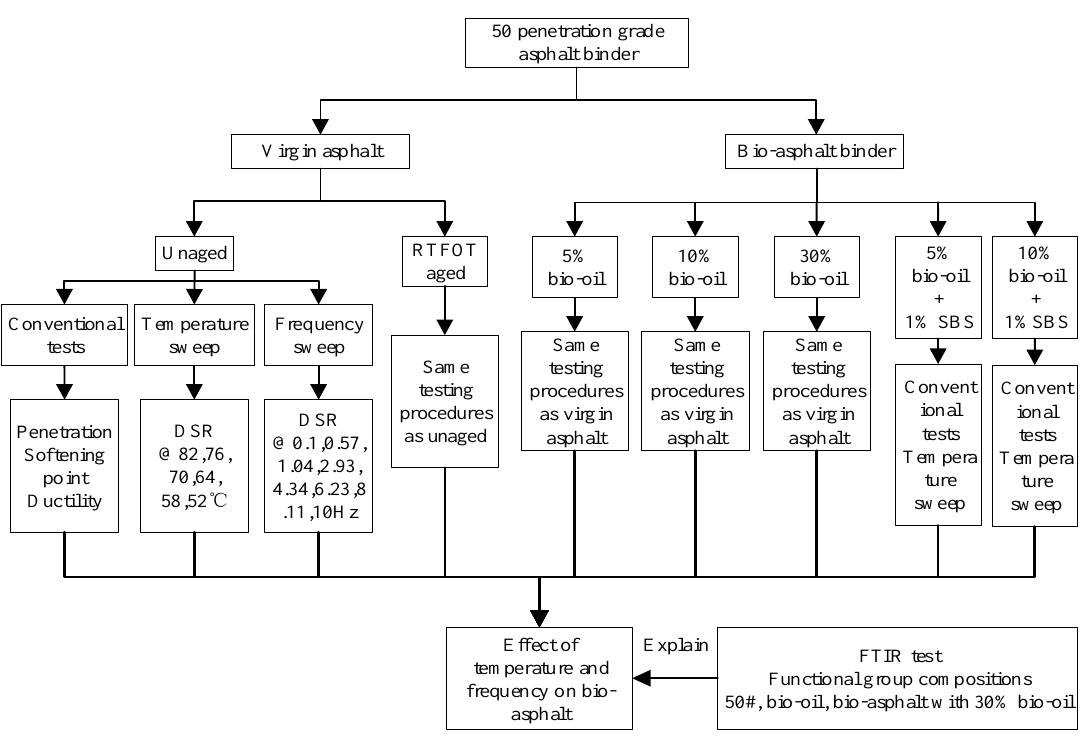
Figure 1. Experimental design map.